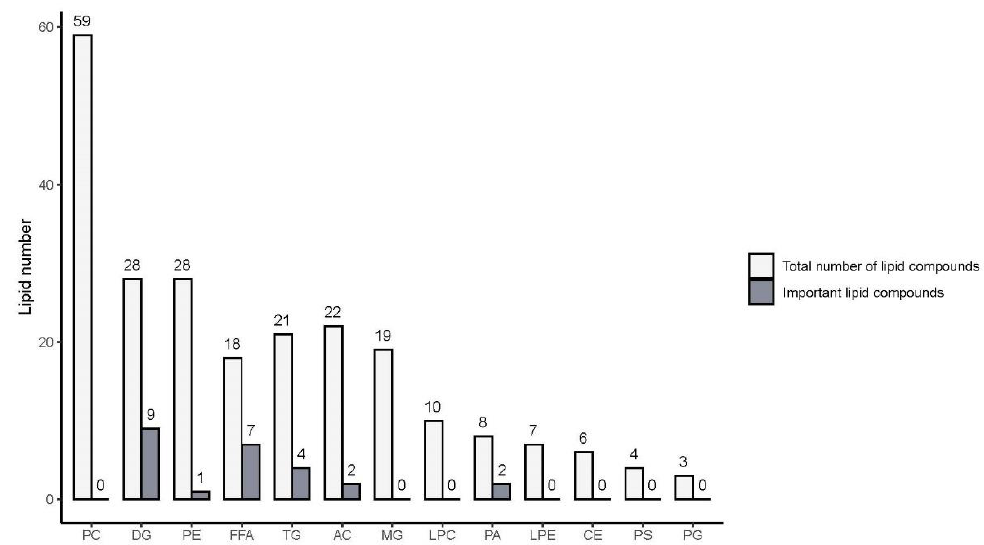
Figure 3. Total number of detected lipid compounds in each lipid class in Pinot noir wine based on a nontargeted lipidomic strategy ( ) and number of important lipid compounds within each class selected by random forest method ( ). See Table 3 for lipid classification names.